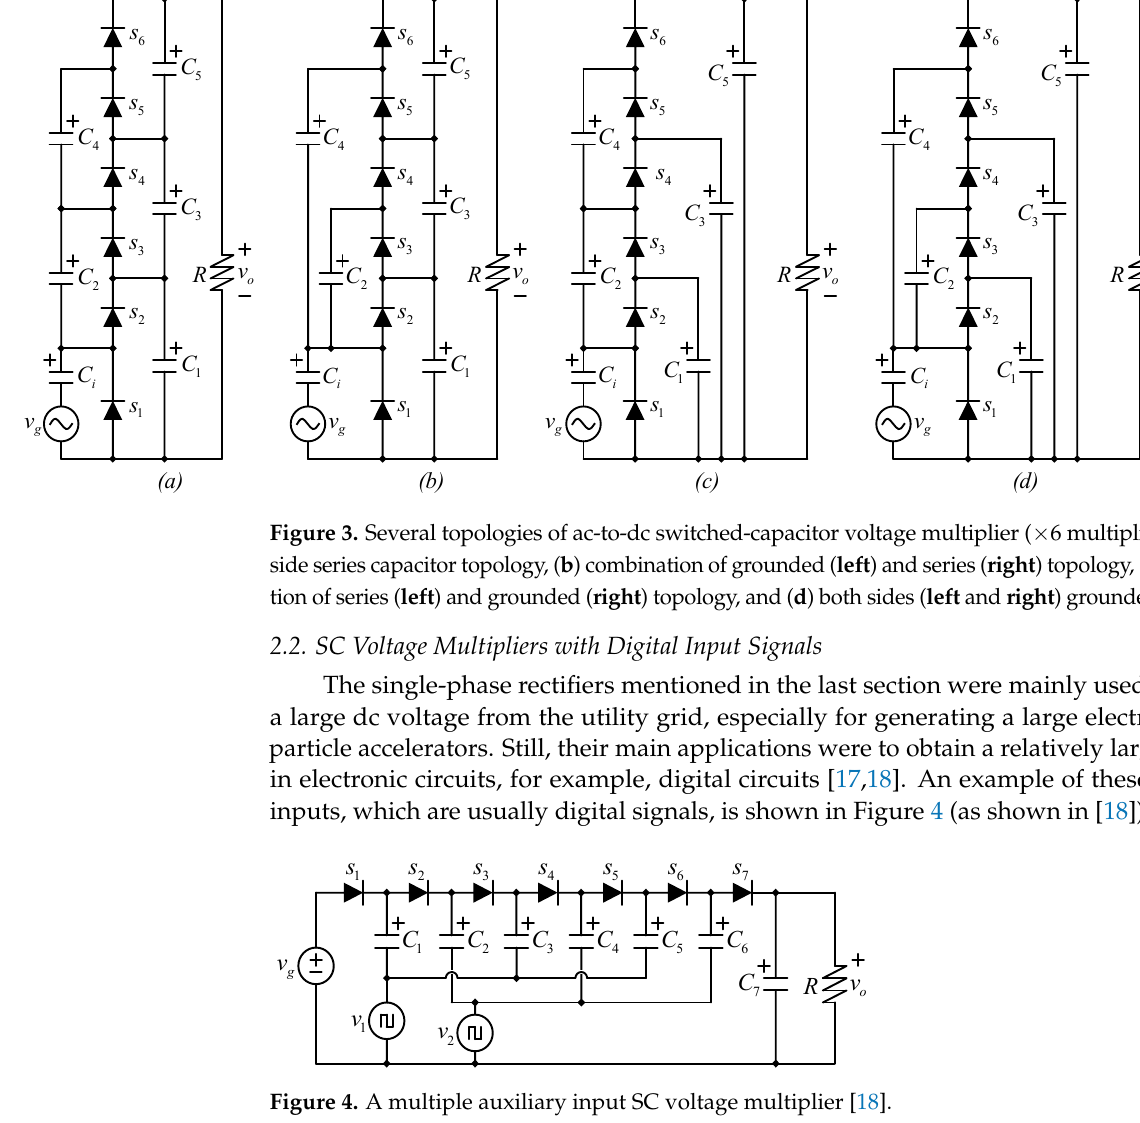
Figure 2. Ac-to-dc switched-capacitor voltage doubler ( a ) topology, ( b ) equivalent circuit when the input voltage is the negative half cycle, ( c ) equivalent circuit when the input voltage is in the positive half cycle.